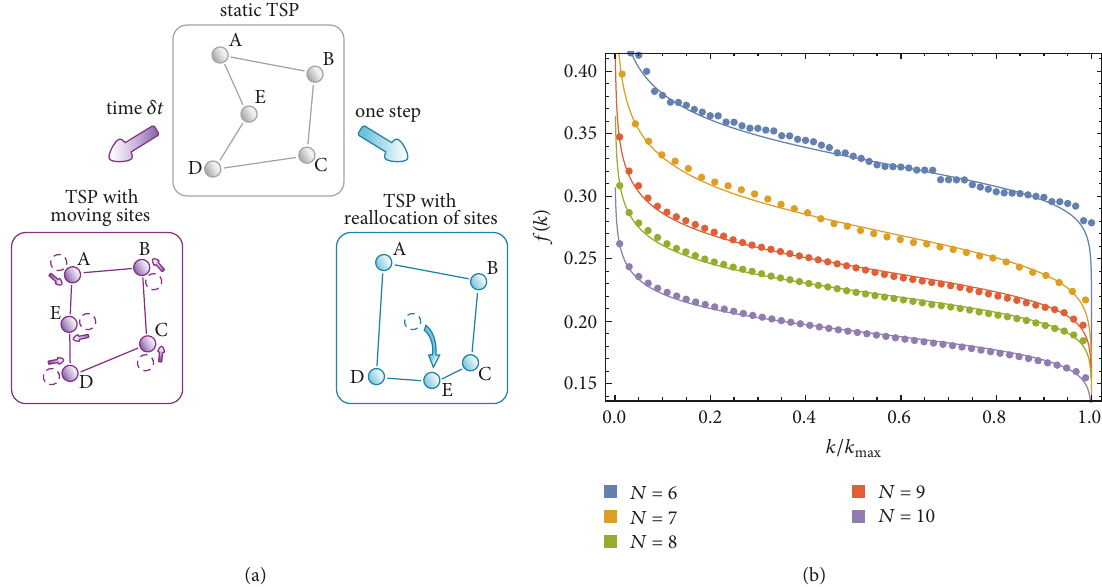
Figure 1: Time-dependent traveling salesman problem with moving sites and with reallocation of sites. Rank distribution for the TSP . (a) Diagram showing the two generalizations of the TSP considered here. By allowing nodes to shift in time, the static TSP (center) becomes time dependent. In the TSP with moving sites (left), these are displaced in a small interval 𝛿𝑡 . In the TSP with reallocation of sites (right), they are displaced to random positions after one time step. In these TSP variations, nodes do not move during path traversals; that is, the optimization problem of finding paths is solved for a static situation. Shortest paths are shown with lines between sites. (b) Rank distribution according to the inverse path length 𝑓(𝑘) , for 𝑁 = 6 to 𝑁 = 10 sites in particular but representative instances of the TSP. Not all points are shown in the figure, so the best fit to a beta function (continuous line) can be clearly seen. We include a proportionality factor to such function to account for the fact that 𝑓(𝑘) is not a probability